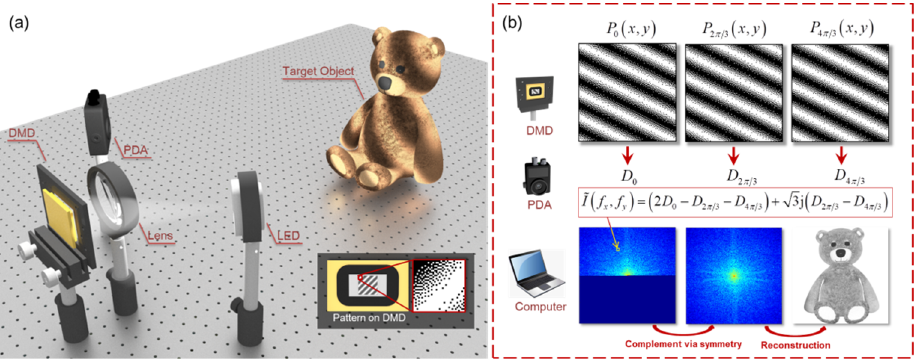
Figure 1. Illustration of three-step phase shifting FSI. ( a ) In a structured illumination-based setup, the object is under illumination of Fourier basis patterns generated by a DMD. The Fourier basis patterns are dithered. ( b ) The object image is retrieved by acquiring the Fourier spectrum of the image. Each complex-valued Fourier coefficient can be acquired by using a set of three-step phase-shifting Fourier basis patterns where the phase shift is 2 π /3. The conjugate symmetry of the Fourier spectrum allows a lossless image to be retrieved with only one half of the Fourier coefficients acquired.